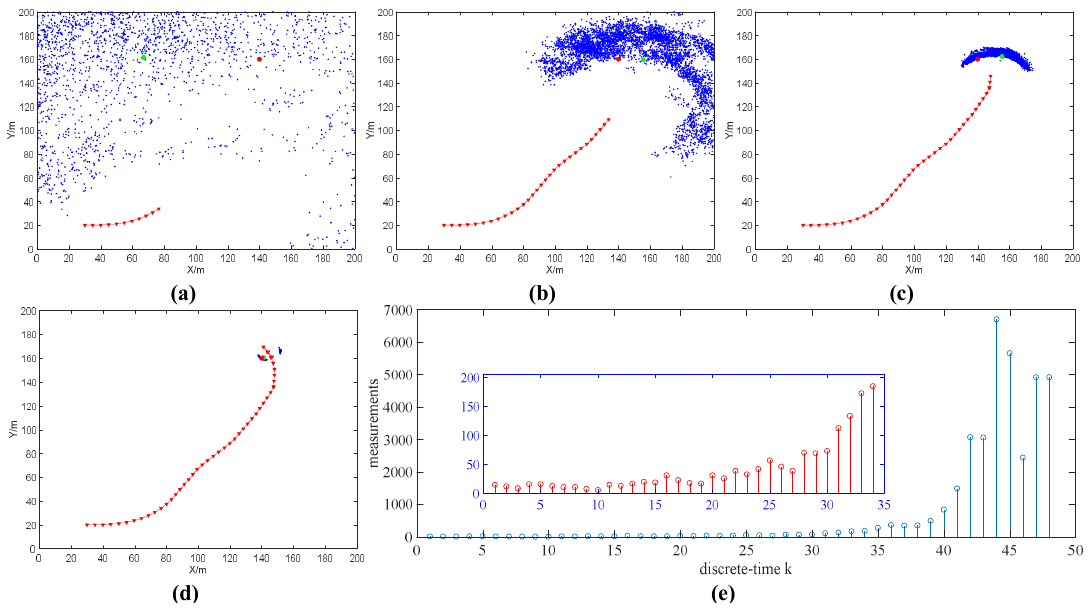
Figure 2. The estimation results of radioactive sources when the number of measurements N = 1 ( a ) k = 20 , ( b ) k = 30, ( c ) k = 40, ( d ) k = 48. In the figure, the blue dot indicates existing particle positions, the green circle indicates the estimated position of the radioactive source, the red circle indicates the true position of the radioactive source, the red line indicates the robot search path and the red triangle indicates the position of the robot. ( e ) Shows the measured value z k obtained during the source search. Table 1. Error of radioactive source estimation under different measurement times.